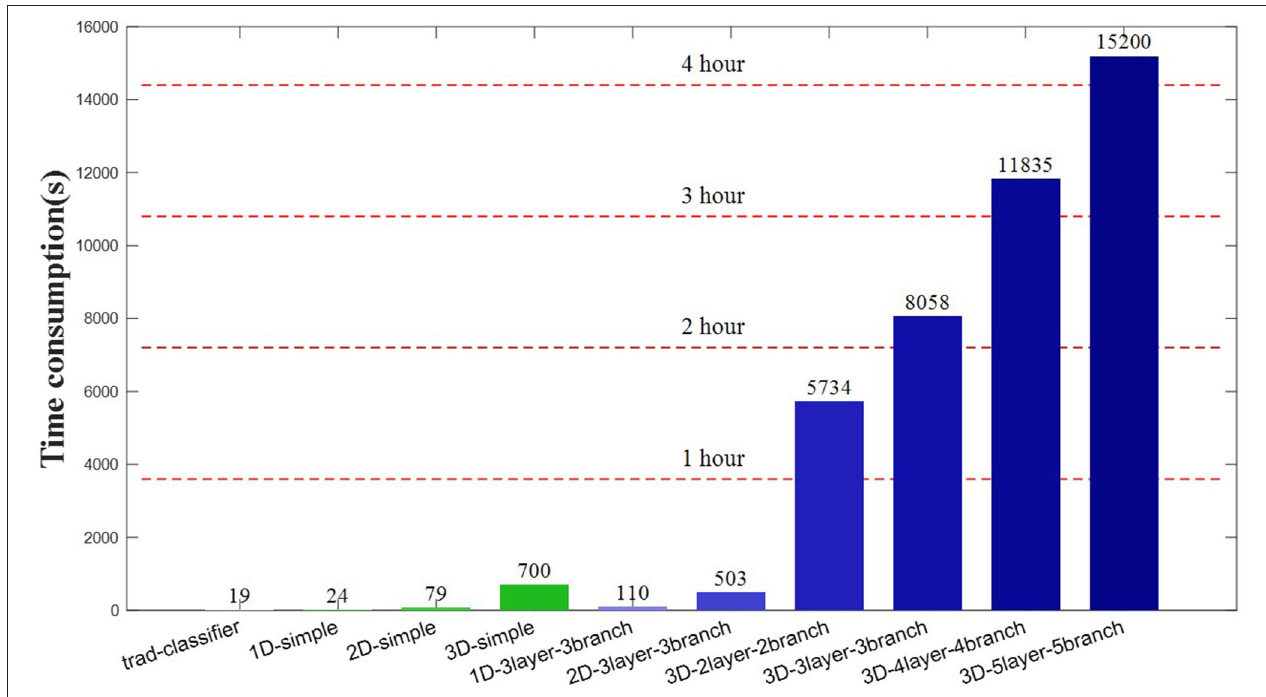
FIGURE 11 | Training time consumption of different EEG authentication